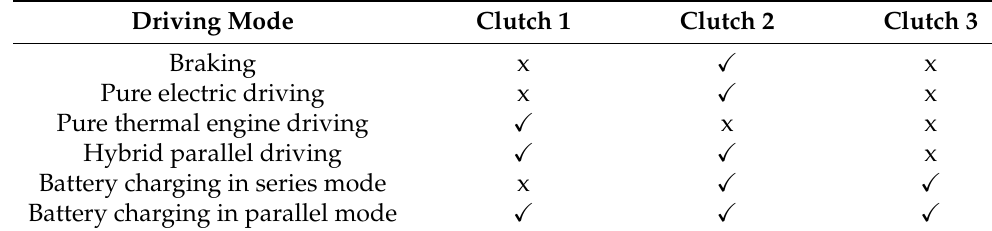
Table 2. Driving modes and clutch positions.